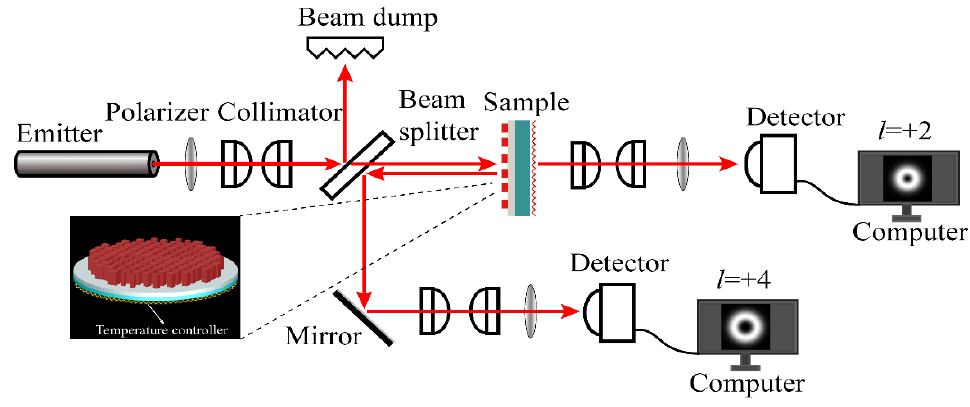
Figure 9. Schematic of the experimental setup.